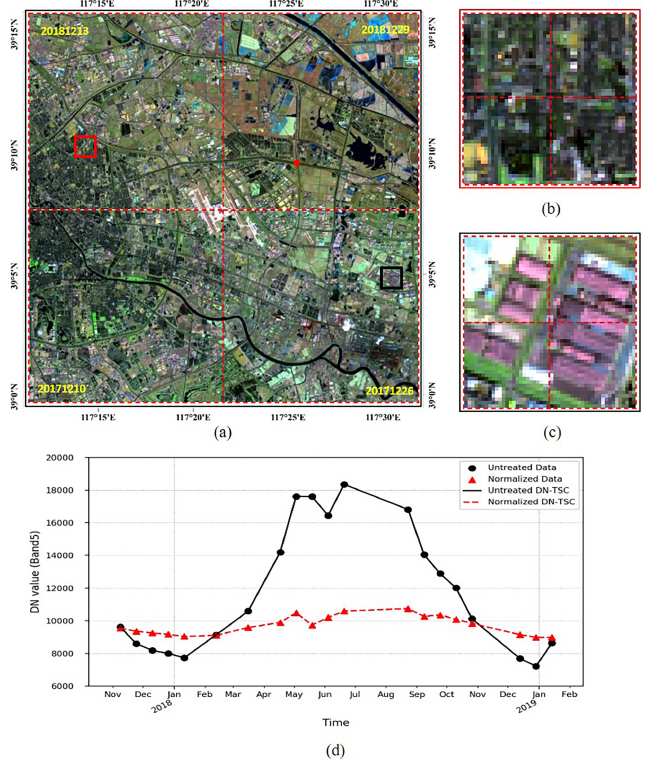
Figure 7. ( a ) The mosaic pattern composed of four normalized images taken from from 10 and 26 December 2017, and 13 and 29 December 2018, respectively. The Resultant images have similiar color and color contrast to each other. ( b )The mosaic pattern of the urban area, and the bundary of this area is marked in red box in a . ( c ) the mosaic pattern of the artificial building area, and the bundary of this area is marked in black box in a . ( d ) The comparison of time-series’ curves of DN values (DN-TSC) from the near-infrared Band (Band 5) for the road pixel (marked in red point in a ) before (marked in black line) and after (marked in red line) radiometric